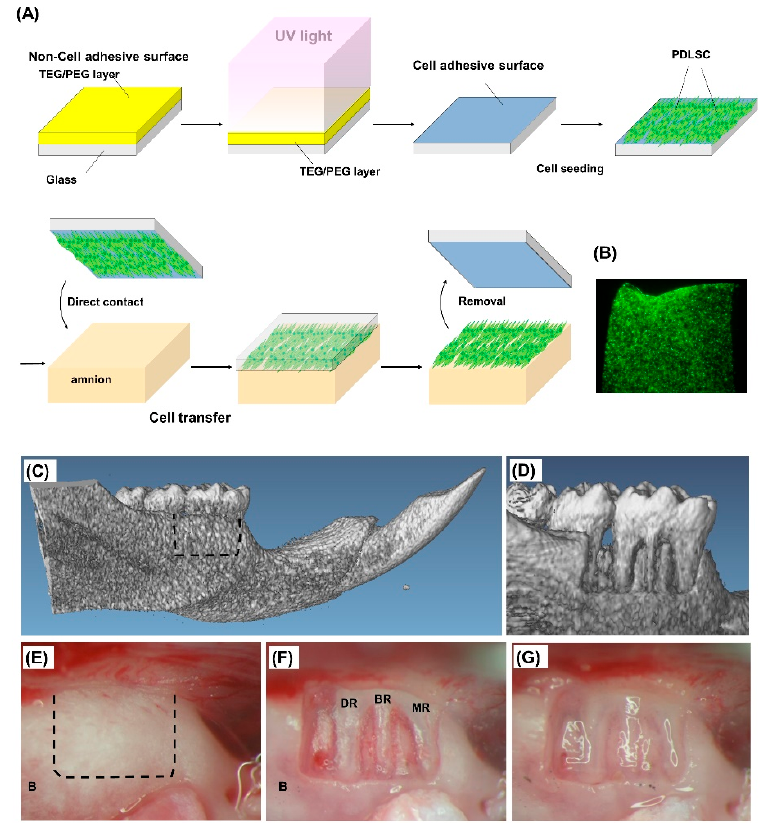
Figure 1. PDLSC transfer on amnion using the cell transfer technology and transplantation into periodontal defects. ( A ) Cultured PDLSCs were transferred onto decellularized amnion surface. The yellow area on the transfer base shows the hydrophobic cell nonadhesive surface and the blue area denotes the hydrophilic cell adhesive surface. Trypsinized PDLSCs were seeded onto blue cell adhesive surface, created by ultra violet light irradiation of the tetraethylene glycol (TEG) or polyethylene glycol (PEG) layer. After incubation for 3 h, PDSLCs adherent to the transfer substrate were placed onto amnion with the cell surface oriented downward. After overnight incubation, the transfer base was removed with forceps and PDLSCs were transferred from the transfer base to the amnion surface. ( B ) Transfer of PDLSC-GFP onto the amnion. GFP-transfected PDLSCs were transferred onto the amnion using the cell transfer technology, and then cut into squares using a surgical knife. PDLSCs were observed in cell sheet format. ( C ) CT image of the buccal side of a rat mandible. The dotted line outlines the periodontal defect. ( D ) CT image of a periodontal defect. By removing bone, PDL, cementum, and dentine, a 2 × 3 mm periodontal defect was created. ( E ) Photograph of a bone surface before periodontal defect creation. The dotted line outlines the periodontal defect. ( F ) Photograph of a periodontal defect. The defect was created from the mesial root of first mandibular to the mesial root of second molar. Exposure of the mesial, buccal, and distal roots of the first molar is evident in the defect. ( G ) Photograph of a periodontal defect after PDLSC-amnion placement. PDLSC-amnion was trimmed to cover the defect with a surgical knife and placed onto the periodontal defect with the cell surface oriented to attach to the denuded